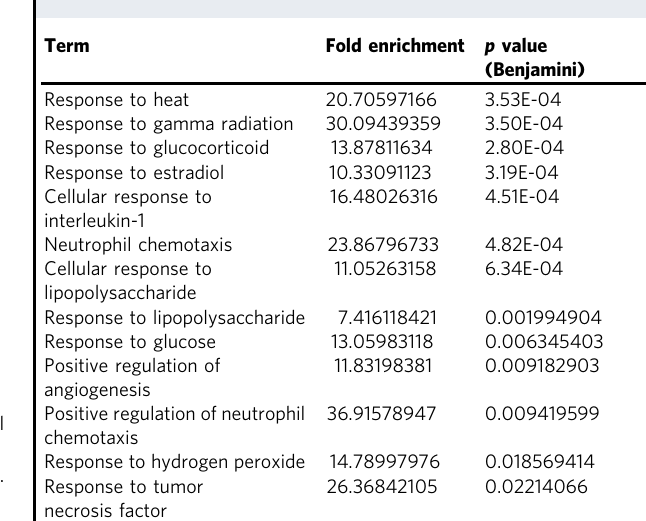
Table 1 Gene ontology for biological processes associated with RFA-mediated thermal injury to normal liver